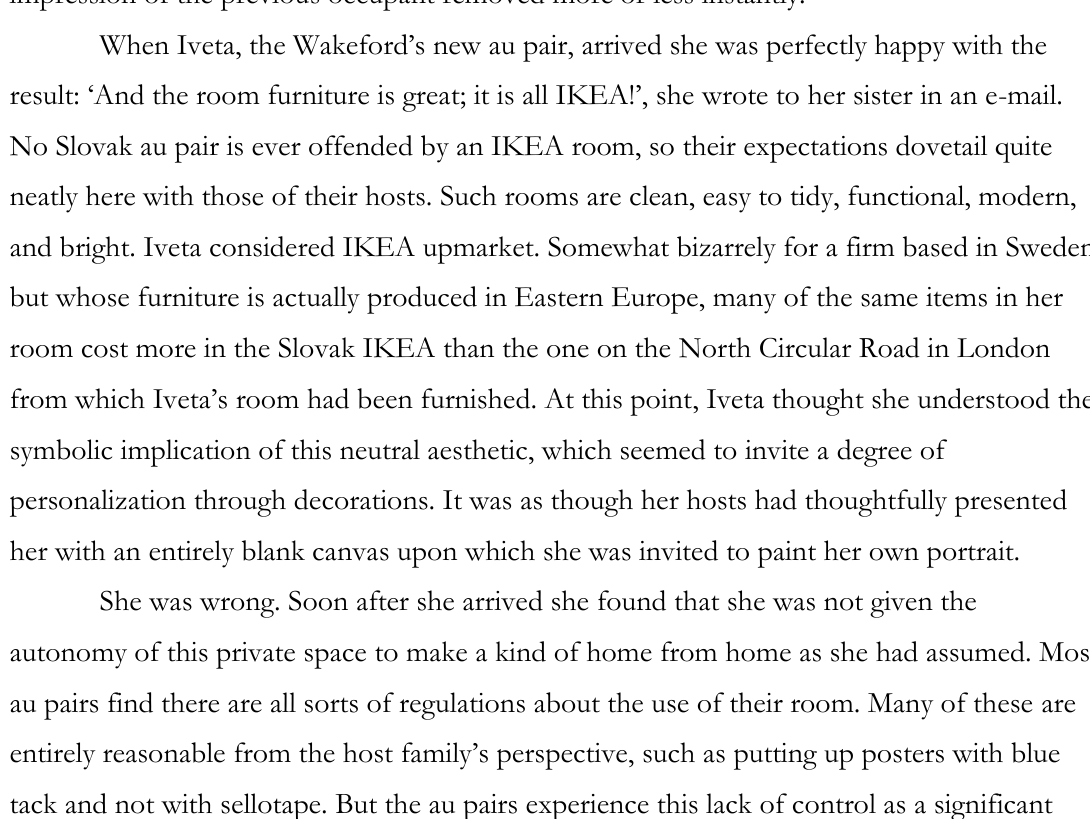
Studies in the Maternal, 3(2), 2011,